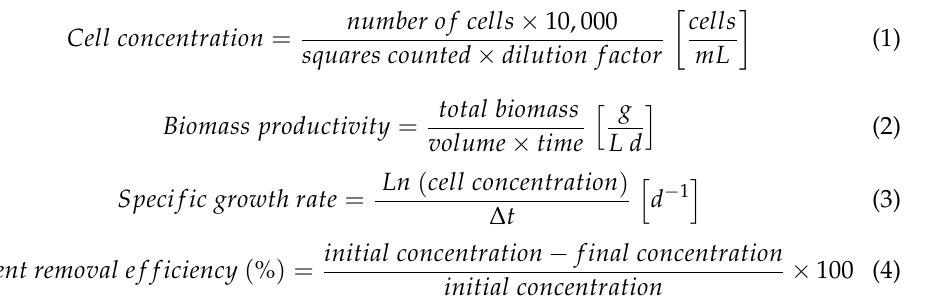
Table 1. Physicochemical characteristics of pig slaughterhouse wastewater used in this study. Initial Value for Parameter Chlorella vulgaris pH 6.5 ±